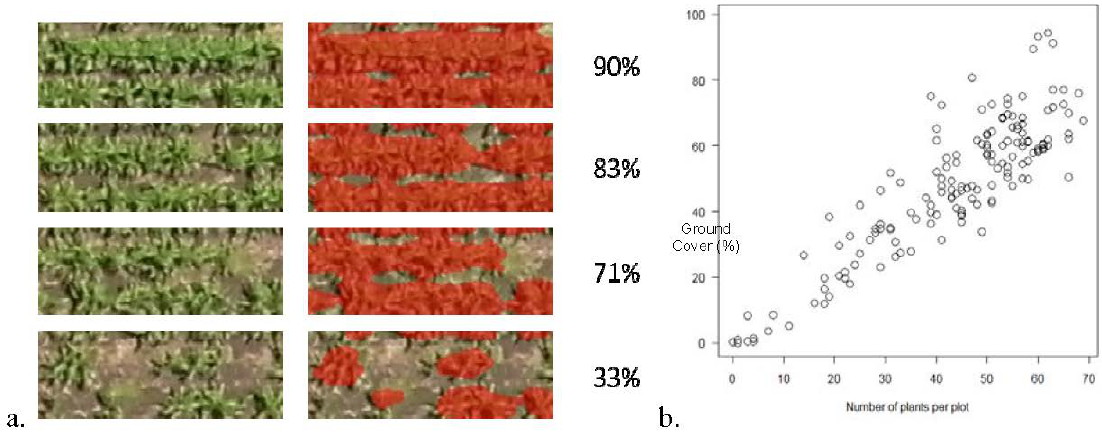
Figure 4. Ground cover at six weeks after planting in a sorghum breeding trial at Warwick, December 21, 2011. ( a ) Four extracted plot images end trimmed at 10% and thresholded (to the right) to estimate green ground cover and ( b ) the correlation ( r 2 = 0.78) between the number of plants per plot and estimated green cover for 100 plots of the trial. Each ground cover point was averaged from at least two or, more commonly, three, images.